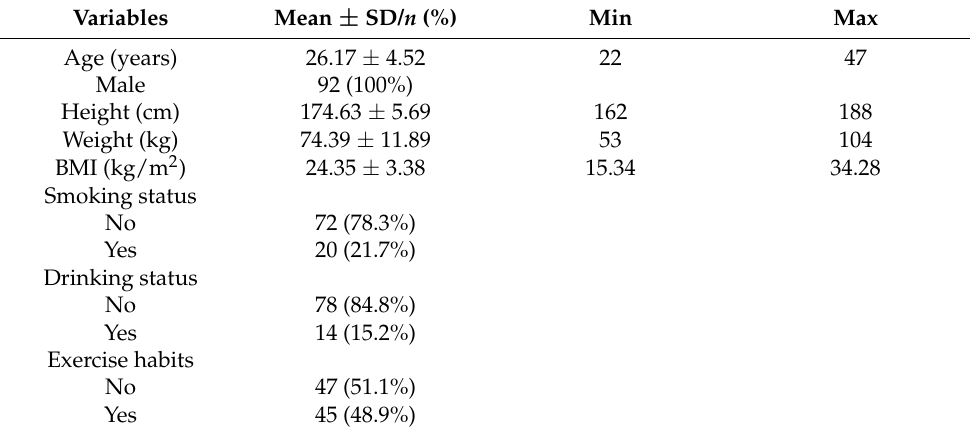
Table 1. Descriptive analysis of demographic